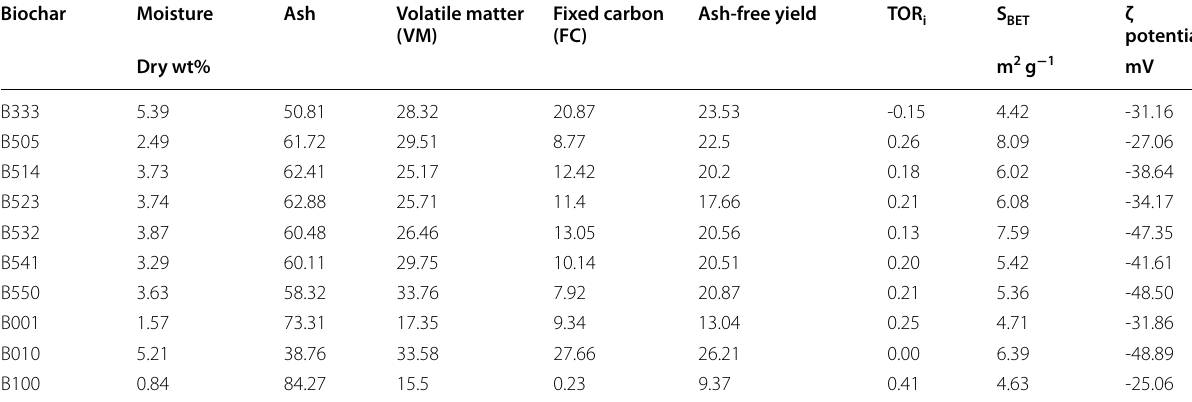
Table 3 Proximate analyses results (water content, ash, VM, and FC), ash-free biochar yield, thermal oxidative recalcitrance (TOR surface area (S ) and zeta (ζ) potential of B-BM and B-MM BET